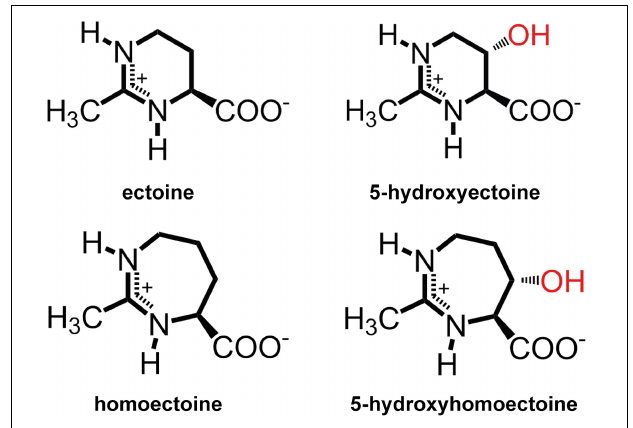
FIGURE 1 | Chemical structures of the compatible solutes ectoine, 5-hydroxyectoine, homoectoine, and